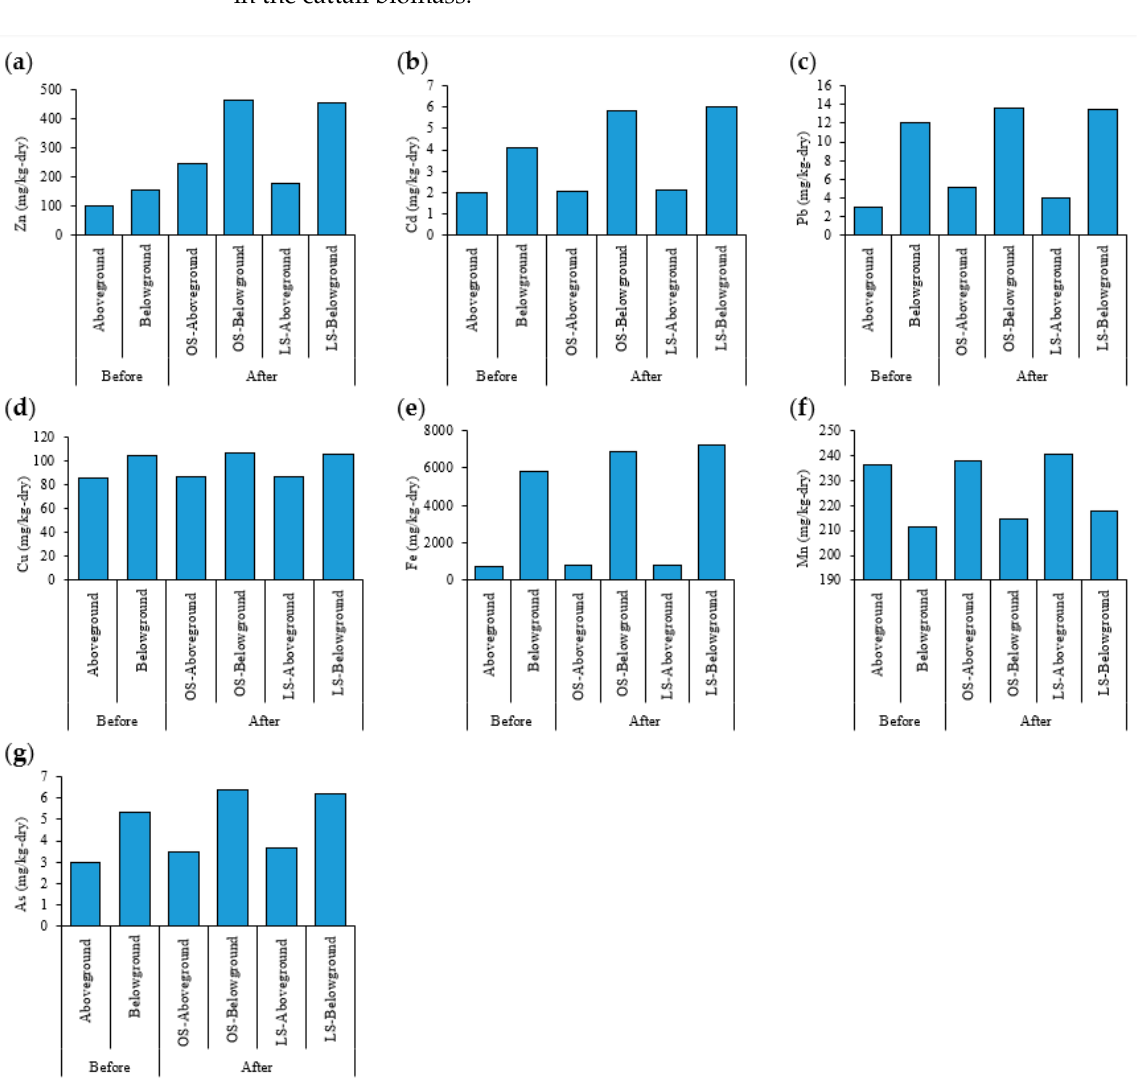
Figure 5. Accumulation of heavy metals in cattails in oyster shell (OS)/limestone (LS)-based CWs before and after 7-month AMD treatment: Zn ( a ), Cd ( b ), Pb ( c ), Cu ( d ), Fe ( e ), Mn ( f ), and As ( g ).